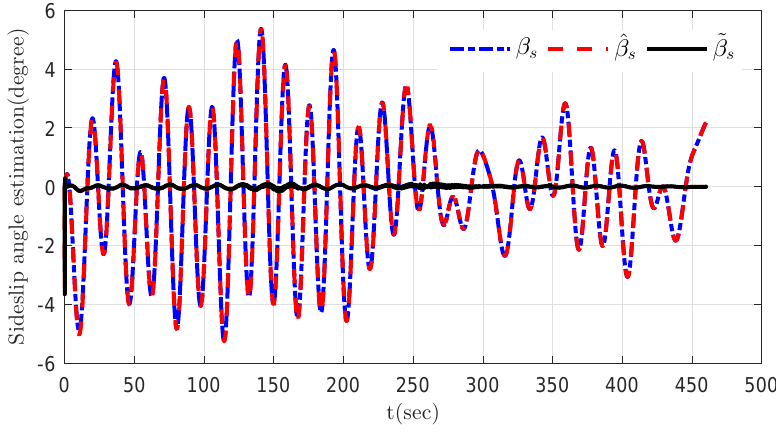
Figure 5. The sideslip angle estimation of the FGO.